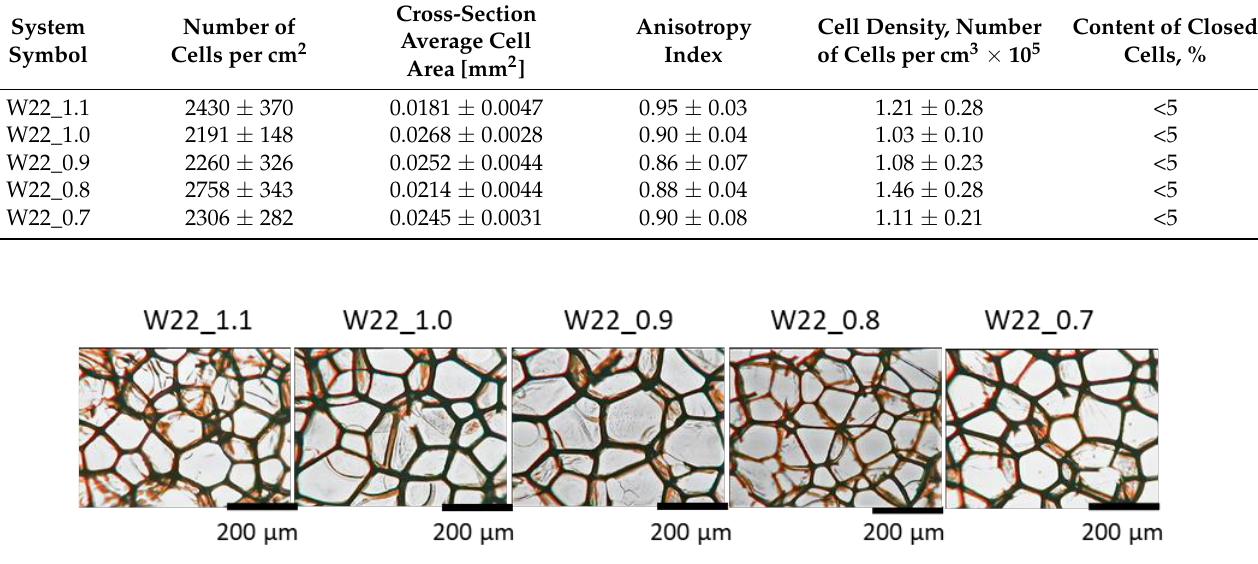
Figure 8. The cellular structure of the foams with different NCO indices examined with the use of an optical microscope.